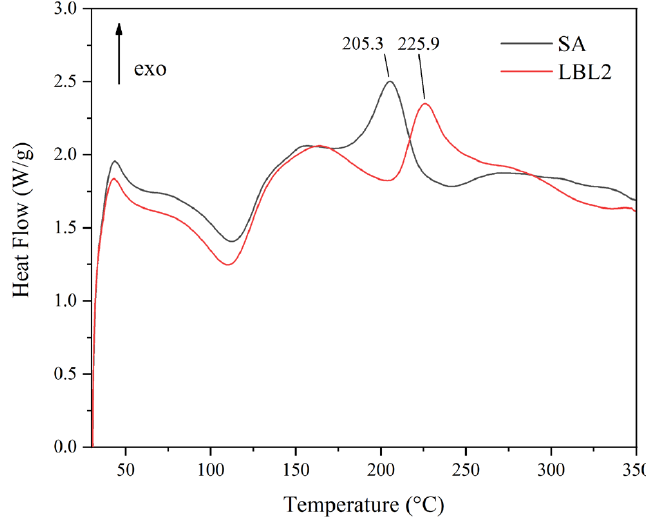
Figure 9. DSC of pure sodium alginate (SA) and LBL2 films.